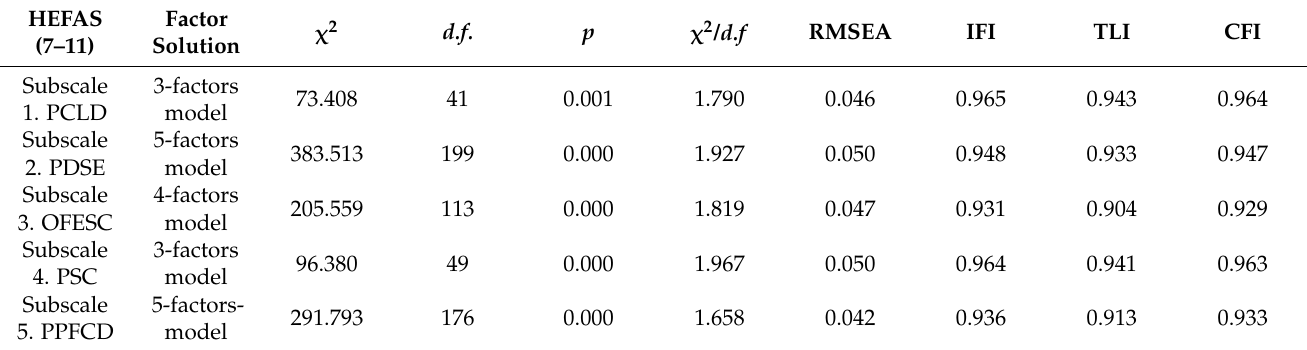
Table 2. Confirmatory factor analysis fit indexes for the five HEFAS subscales.